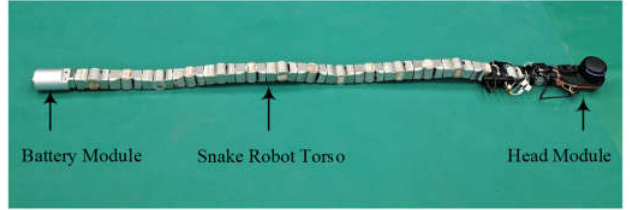
Figure 1. Snake robot integration.